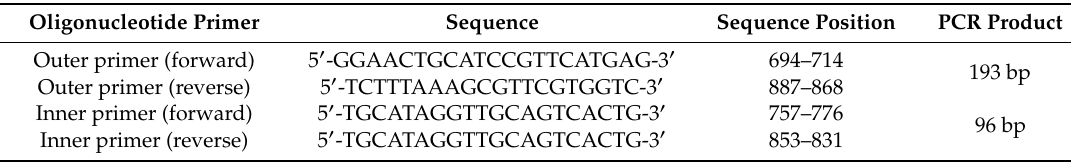
Table 1. Outer (forward and reverse) and inner (forward and reverse) primer sequences for Toxoplasma gondii B1 gene used for the detection of T. gondii DNA in meat